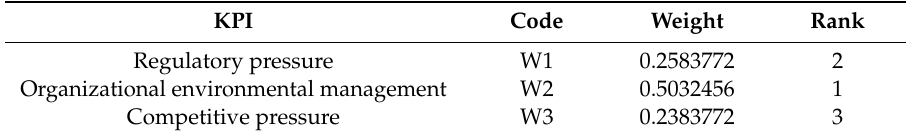
Table 14. Weight and ranking of KPIs in environmental indicators category (taken from fuzzy nonlinear model).